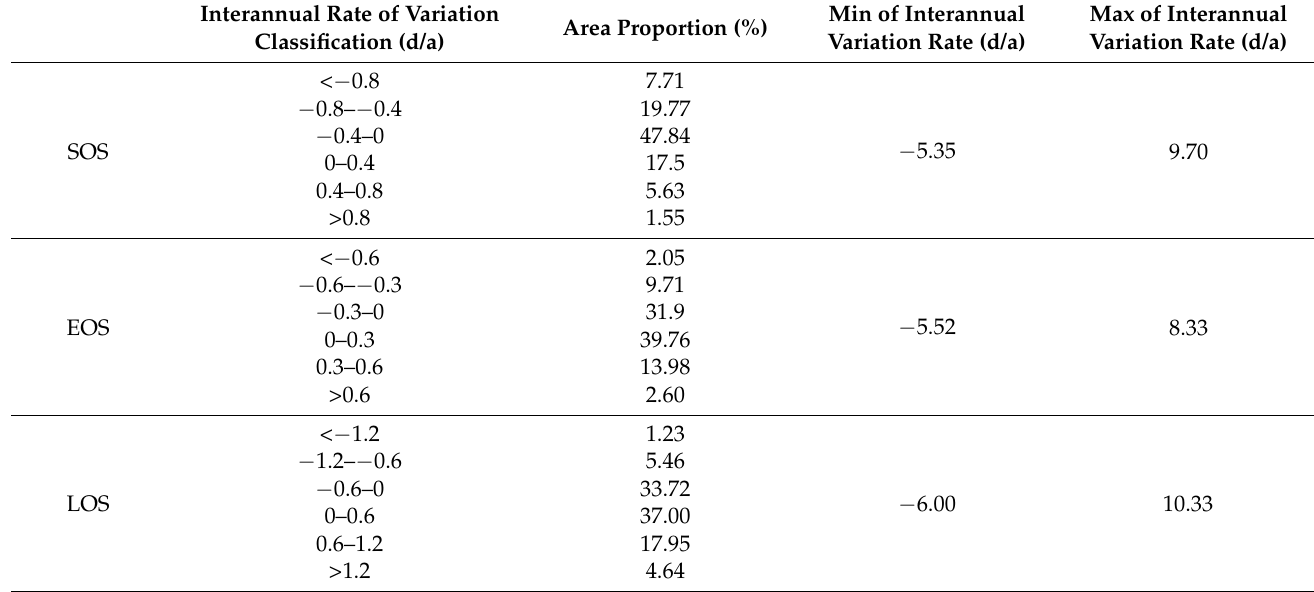
Table 1. Statistics of the variation trend of the SOS, EOS and LOS of the vegetation in the Three-River headwaters region from 2001 to